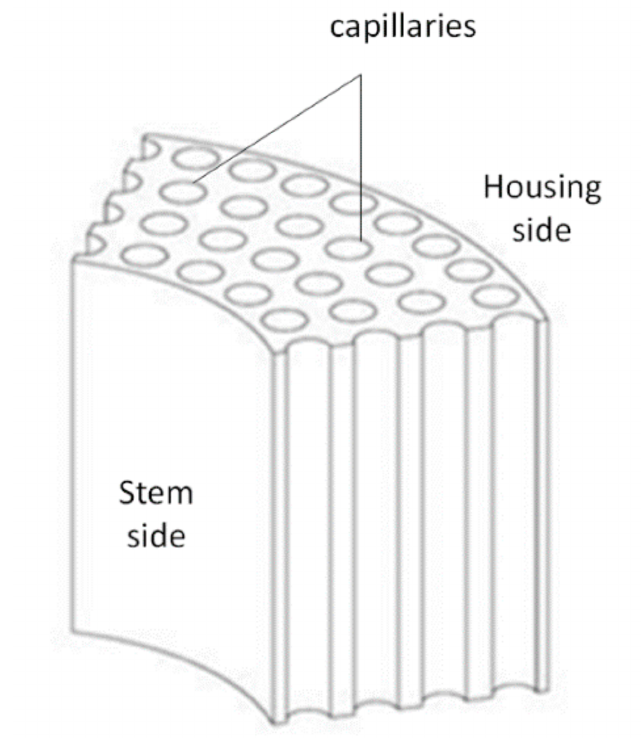
Figure 1. Capillary tubes in a simulated packing